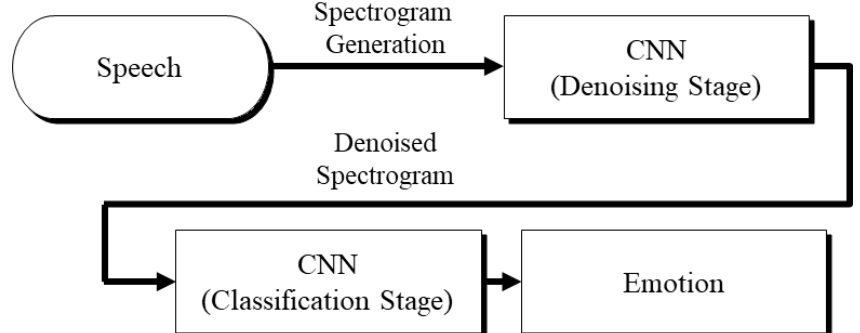
Figure 1. Block diagram of the proposed DnCNN–CNN architecture.